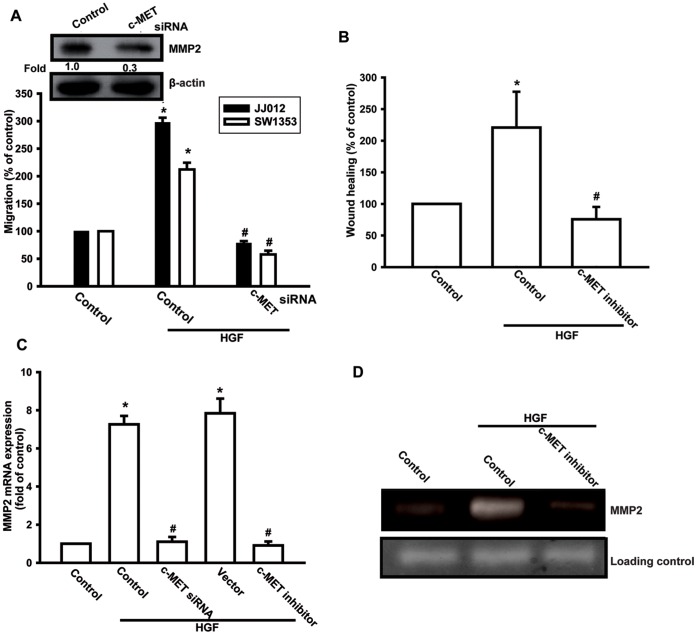
c-Met receptor is involved in HGF-mediated migration in human chondrosarcoma cells.(A–D) Cells were pretreated with the c-Met inhibitor (3 µM) for 30 min or transfected with c-Met siRNA for 24 h, followed by treatment with HGF for 24 h; cell migration and MMP-2 expression were then examined by Transwell, wound healing, qPCR, and zymography assays. Results are expressed as mean ± S.E. *p<0.05 compared with control; #p<0.05 compared with HGF-treated group.